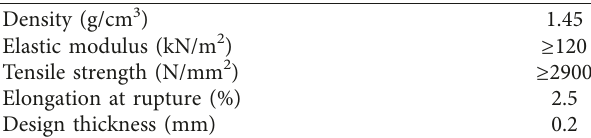
Table 2: Characteristics of the aramid fibres.